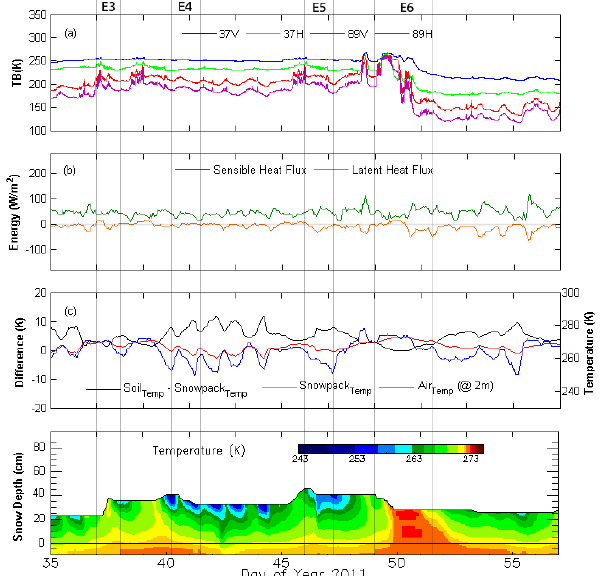
Fig. 4. Time series under accumulating and melting snow phases during mid-winter period. The quantities shown are the same as those described in Fig. 3.